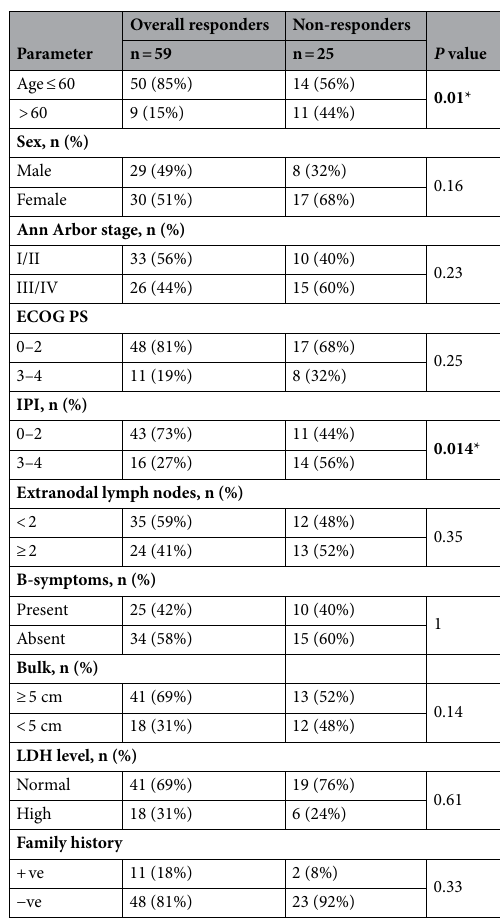
Table 2. Clinical data of overall responders and non-responders to R-CHOP therapy. Data are expressed as number (percentage). IPI International Prognostic Index, LDH lactate dehydrogenase, PS performance status. *Indicates statistical significance P <